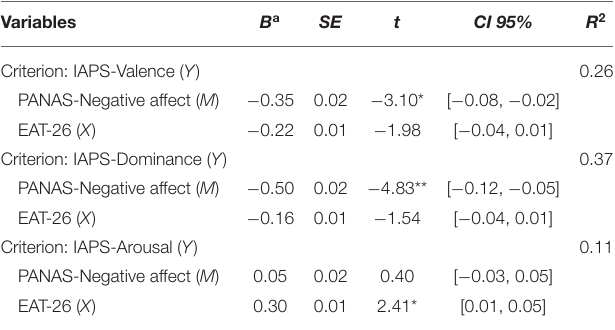
TABLE 2 | Regression coefficients and summary of the three mediation models.